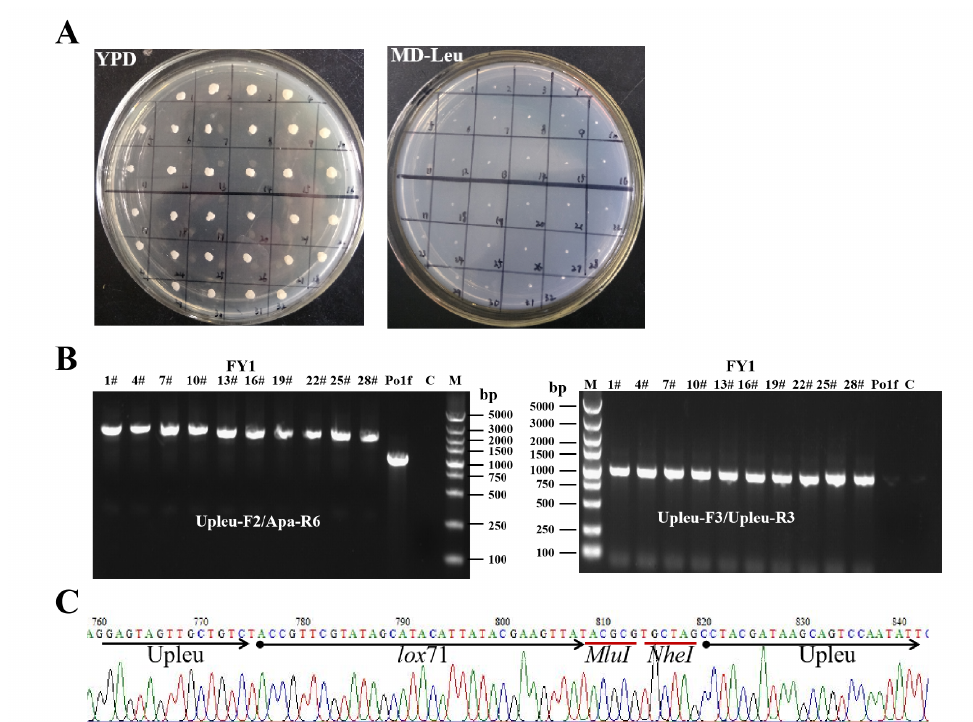
Figure 2. ( A ) Isolation of positive colonies in the first-round integration. A total of 32 recombinants were randomly selected and inoculated onto YPD and MD-Leu media, and none of them could grow on MD-Leu medium. ( B ) PCR amplification to identify positive colonies in the first-round integration. Lane M, Marker; lane C, ddH 2 O. PCR products of about 2400 bp (corresponding to Upleu- lox 71- Upleu-partial leu2-270 in FY1 genome) and about 1300 bp (corresponding to Upleu-partial leu2-270 in Po1f genome) were, respectively, amplified by primer pair Upleu-F2/Apa-R6. The PCR product corresponding to Upleu- lox 71-Upleu (about 1000 bp) was obtained using primers Upleu-F3/Upleu- R3 in the FY1 strain; however, no product was obtained in the Po1f strain. ( C ) Partial sequencing result for the Upleu- lox 71-Upleu PCR product from the FY1